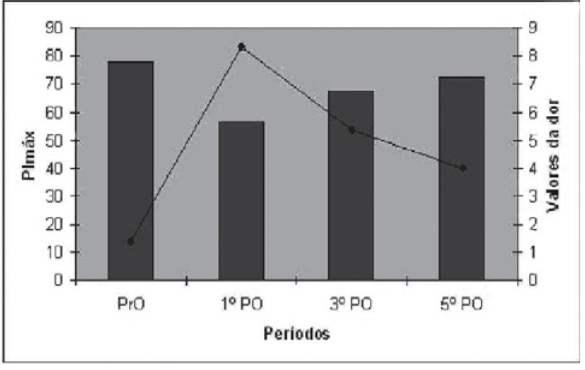
Fig. 2 - Correlação entre a PI e dor referida na esternotomia máx nos momentos PrO, 1ºPO, 3ºPO e 5ºPO) . (*) P < 0,019. - Legenda: 1ºPO = primeiro dia de pós-operatório; 3ºPO = terceiro dia de pós-operatório; 5ºPO = quinto dia